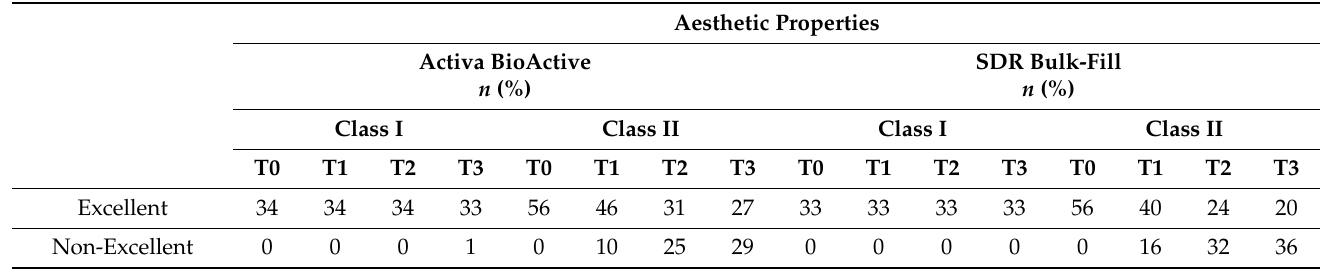
Table 6. Overall evaluation of aesthetic properties based on material used and restoration